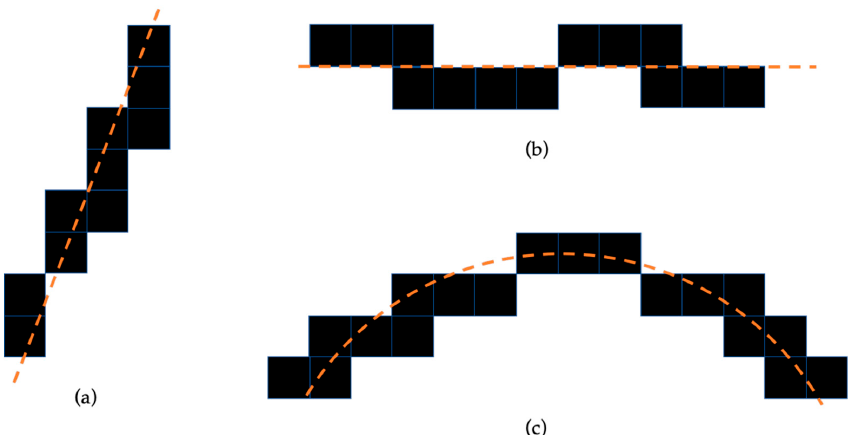
Figure 3. Illustrative schemes, showing typical clusters of edge pixels obtained after the application of Canny edge detector to GPR data: ( a ) group of edge pixels that can be fitted by using a linear function with non-zero slope; ( b ) group of edge pixels that can be fitted by using a linear function with zero